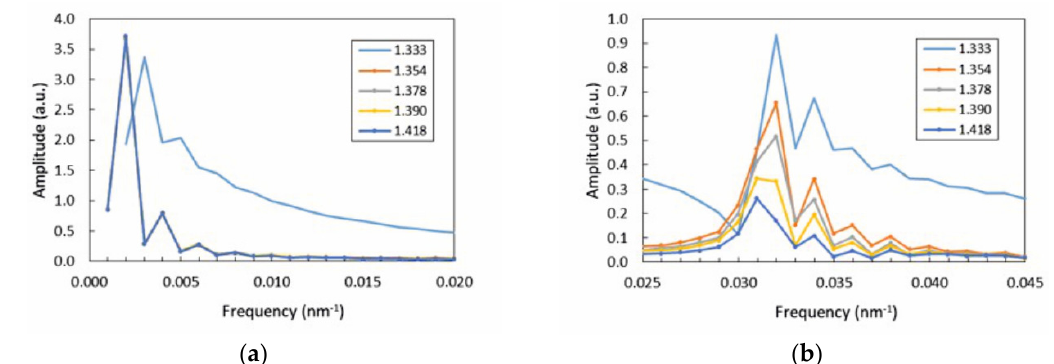
Figure 12. Frequency amplitude plots within the peaks considered for spectral analysis of the FP ‐ long sensor ( L 1 = 80 μ m and L 2 = 22.7 cm): (a) Peak 1 and (b) Peak 2.